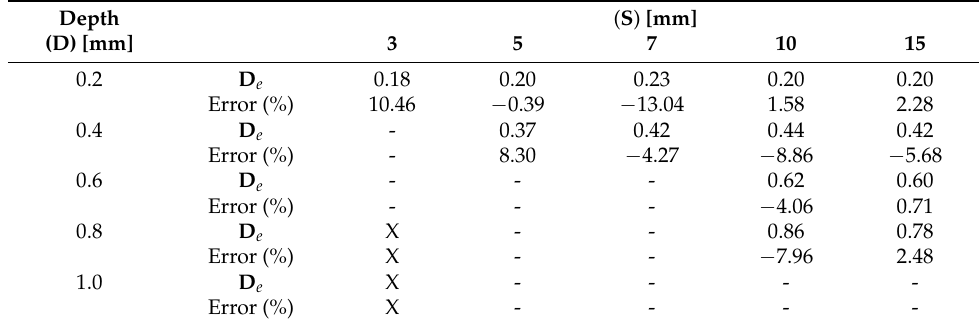
Table 8. Estimated depths ( D e ) and relative percentage errors (%) of defects for maxigrams of actual thermal sequences processed by the BTCOp